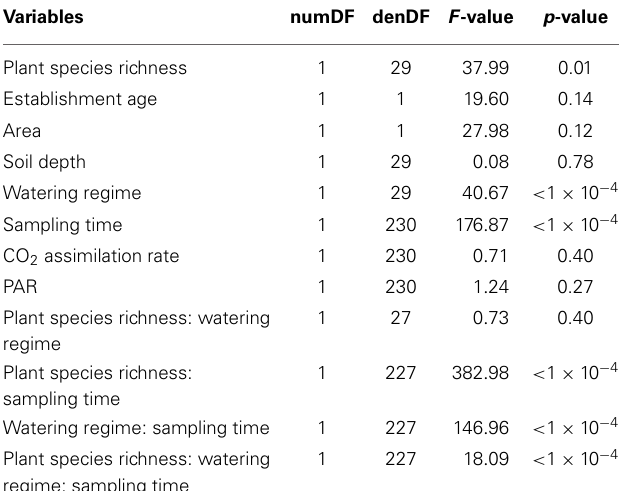
Table 2 | Results from a Wald test of a linear mixed effect model with the response variable plant cover conducted to assess